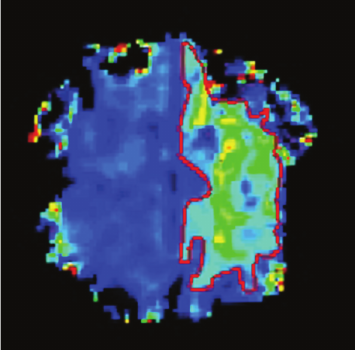
Figure 2: 0h after MCAO PWI (MTT) shows delayed MTT lesion.